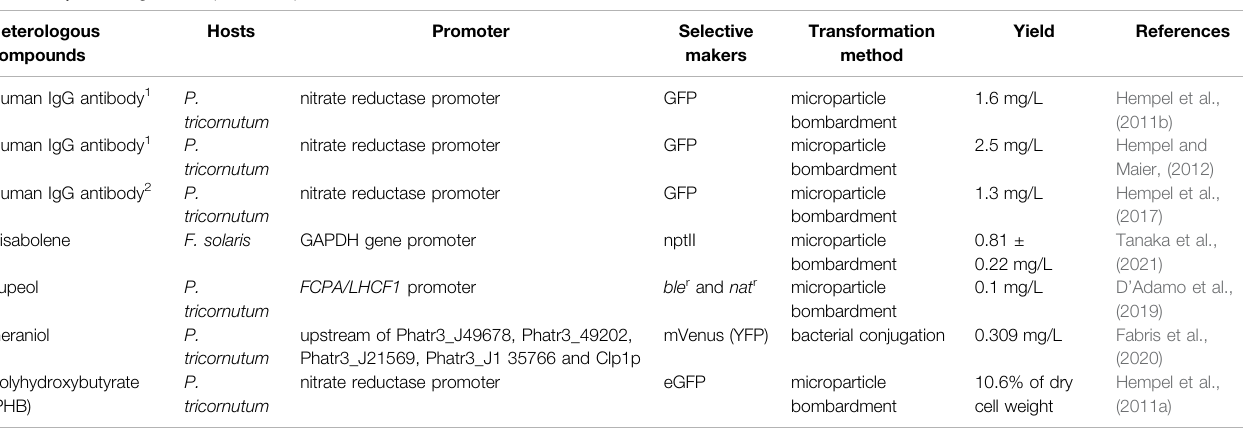
TABLE 3 | Heterologous compounds expressed in